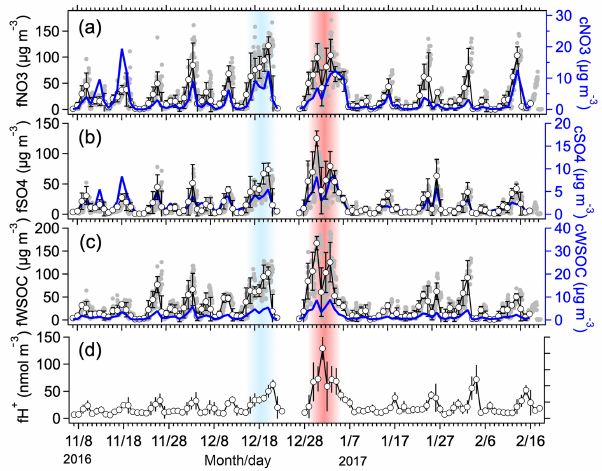
Figure 3. Temporal variations in mass concentrations of nitrate (a) , sulfate (b) and water-soluble organic carbon (WSOC) (c) in fine mode and coarse mode, and acidity of particle ( f H + ) in the fine mode (d) . Gray dots and white circles represent hourly- and daily- averaged values, respectively.